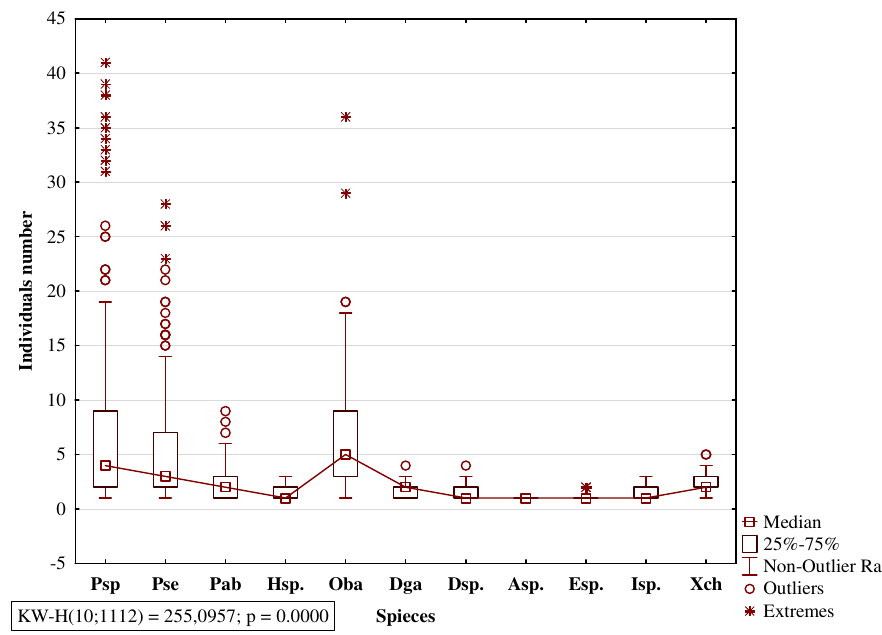
Figure 3. Individuals number of ectoparasites depending on species Individuals number of ectoparasites depending on